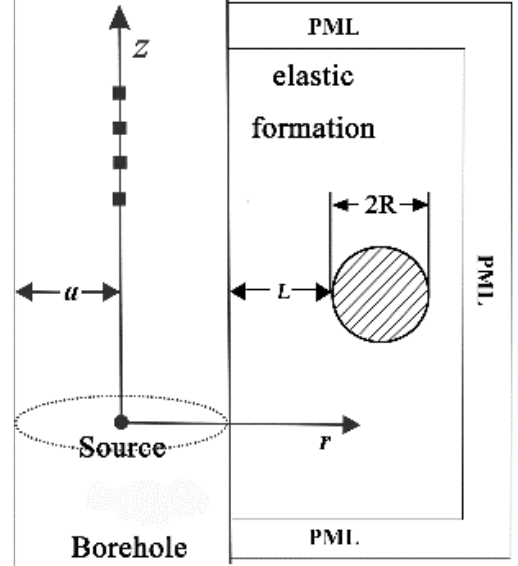
Figure 2. Schematic diagram of a cave formation in a borehole. The radius of the cave is R , the distance of the cave to the borehole wall is L , the radius of the borehole is a , a = 10 cm, and the source and receiver are placed in the borehole. The source is located under the cave; the vertical distance from the cave is 2 m. Perfect-matched layer (PML) is an absorbing boundary region. r is the radial coordinate and z is the axial coordinate of the borehole. Energies 2020 , 13 , x FOR PEER REVIEW